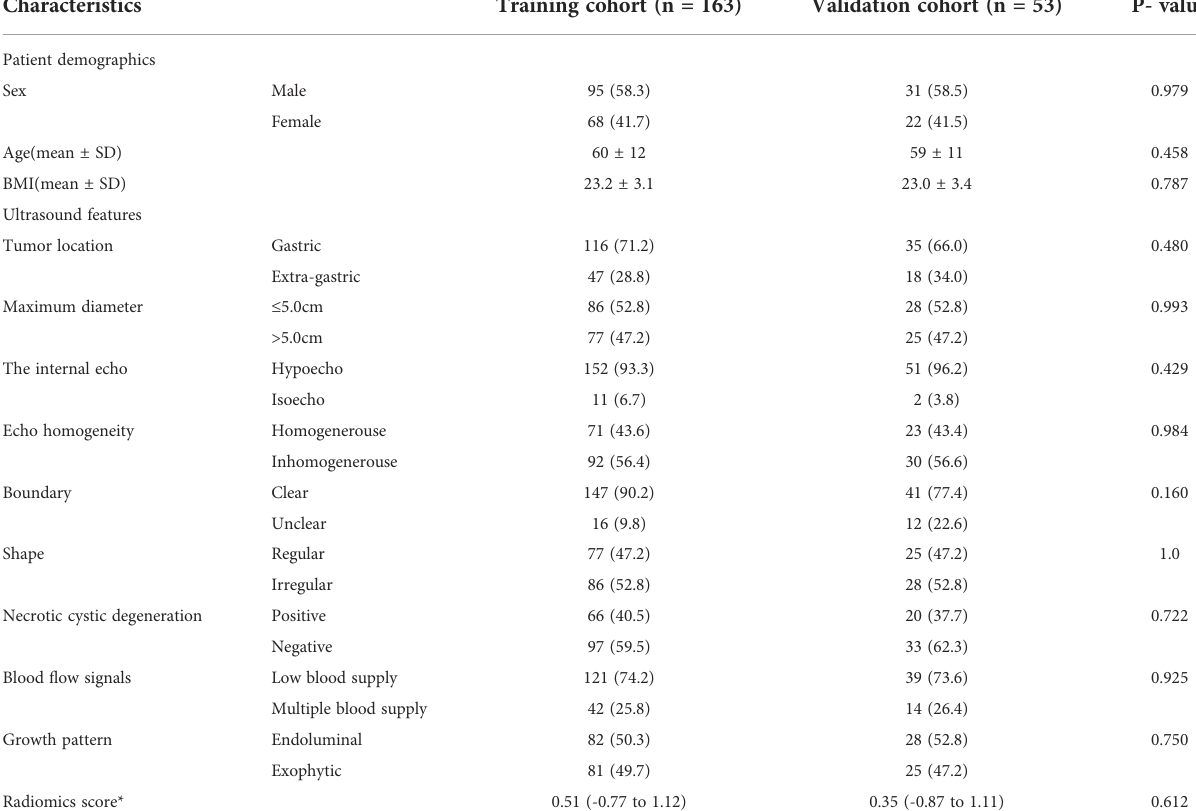
TABLE 1 Baseline Patient